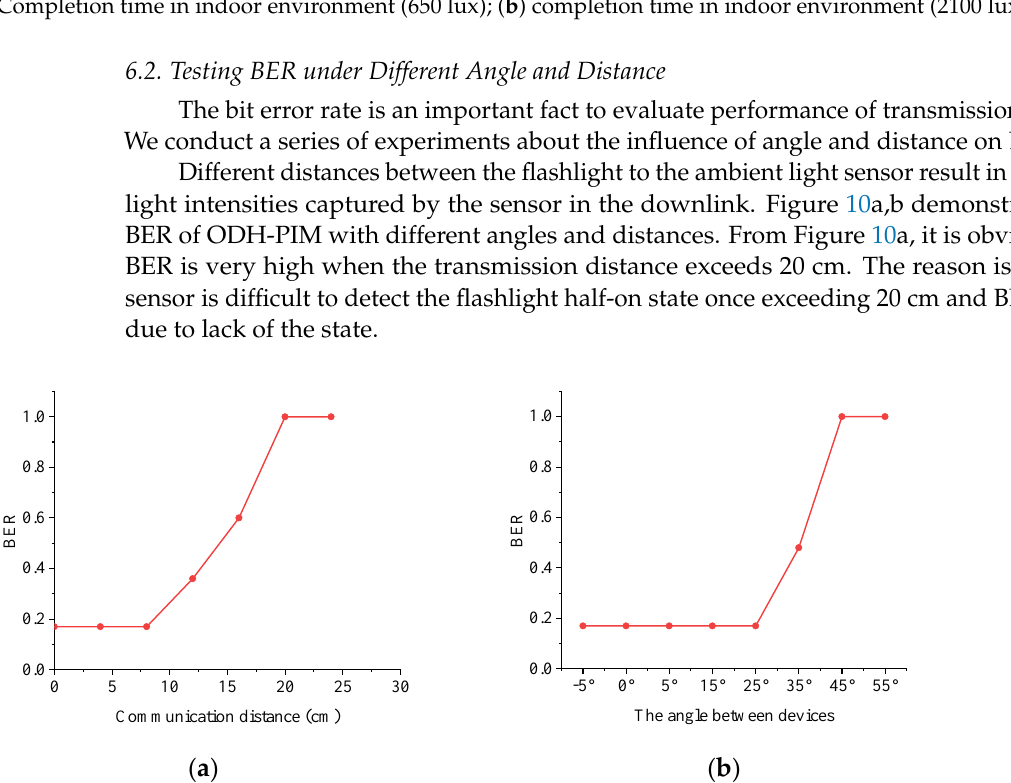
Figure 9. ( a ) Completion time in indoor environment (650 lux); ( b ) completion time in indoor environment (2100 lux).